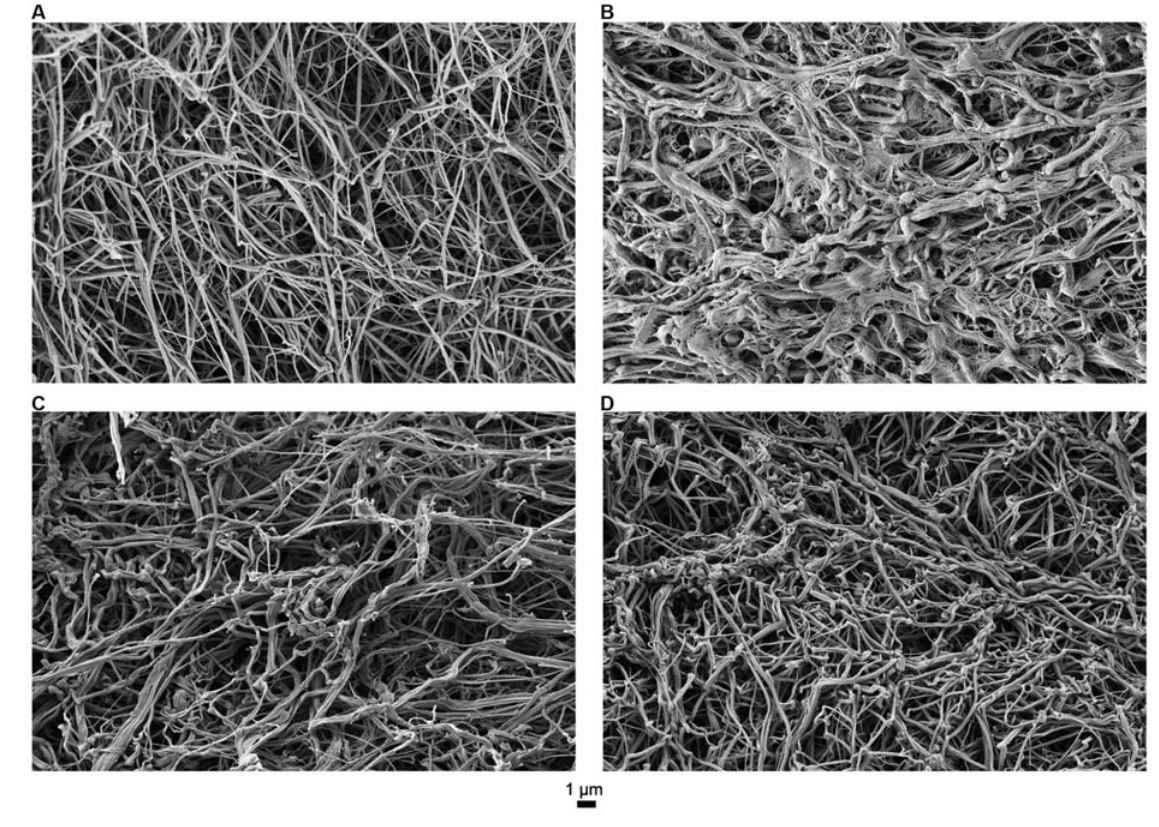
Fig. 2 Representative scanning electron microscopy images of fi brin clots. ( A ) Pooled normal plasma; ( B ) FVIII-de fi cient plasma; ( C ) SIA 200 nM; ( D ) SIA 600 nM. F, factor; SIA, sequence-identical